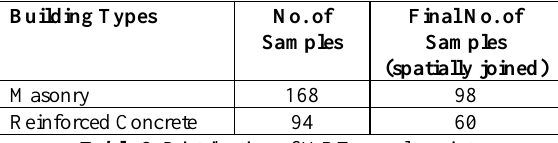
Table 2. Distribution of MBT sample points.